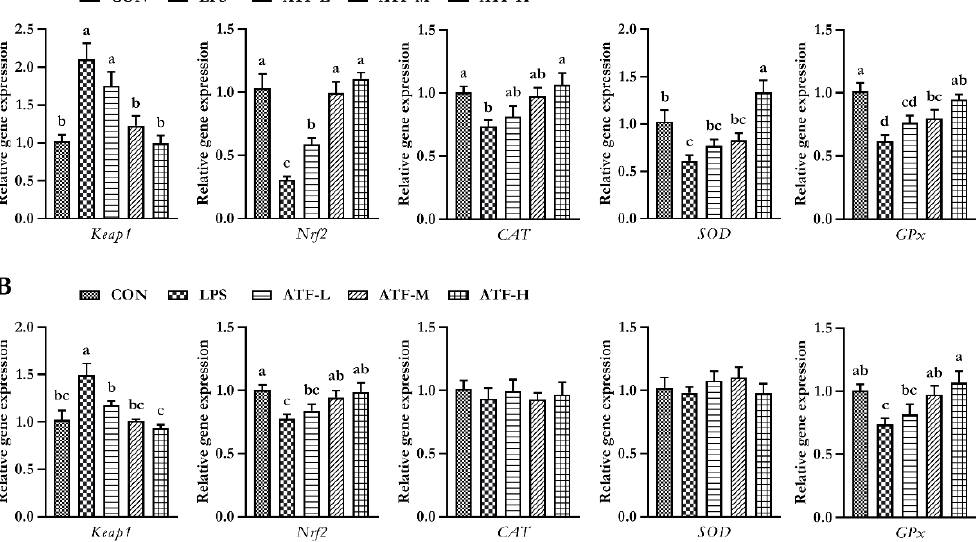
Figure 2. Effect of ATF on the expression of antioxidant-related genes in the spleen of broilers challenged with LPS. ( A ) The data of antioxidant-related gene expression in the spleen of broilers at 28 days. ( B ) The data of antioxidant-related gene expression in the spleen of broilers at 42 days. Abbre- viations: Keap1, Kelch-like ECH-associated protein-1; Nrf2, nuclear factor-erythroid 2-related factor 2; CAT, catalase; SOD, total superoxide dismutase; GPx, glutathione peroxidase; ATF, Artemisia or- dosica alcohol extract; CON, non-challenged broilers fed a basal diet; LPS, lipopolysaccharide-chal- lenged broilers fed a basal diet; ATF-L, lipopolysaccharide-challenged broilers fed a basal diet sup- plemented with 500 mg/kg ATF; ATF-M, lipopolysaccharide-challenged broilers fed a basal diet supplemented with 750 mg/kg ATF; ATF-H, lipopolysaccharide-challenged broilers fed a basal diet supplemented with 1000 mg/kg ATF. Each value is shown as the mean and standard error of mean (SEM) ( n = 6); Bars with different letters (a, b, c, and d) are significantly different ( p < 0.05), while bars with the same letter indicate no significant difference between groups ( p ≥ 0.05 ). 4. Discussion The study of safe and environmentally friendly herbal extracts has recently gained much attention on account of their potent bioactivities, such as antioxidant and anti-in- flammatory effects. Nonetheless, how different extracts from different medicinal plants regulate the balance between ROS and antioxidants triggered during oxidative stress re- mains to be further investigated. In the present experiment, we applied a classical E. coli LPS-stimulated model to induce oxidative injury in broilers by intraperitoneal administra- tion of LPS and evaluated the effect of ATF on an LPS-induced oxidative stress broiler model. In the current study, we found that LPS challenge decreased the BW and ADG in both the stress period and convalescence compared to those in the unchallenged broilers, which was possibly due to simultaneously compromised ADFI. This is consistent with the findings of Li et al. [32] and Yang et al. [50], where LPS-induced growth retardation was reported in broilers exposed to 500 μg/kg BW LPS. This phenomenon could be linked to the diversion of dietary nutrients from growth to support inflammatory-related processes, such as the synthesis of cytokines and various acute proteins [51]. Another possible reason for the observed phenomenon could be the ability of the overproduction of inflammatory cytokines to lose appetite via the control of the hypothalamic − pituitary − adrenal axis-as- sociated antioxidant process, which was reflected in the decrease of ADFI in the LPS group broilers in the present study [52]. We also observed that dietary ATF alleviated the decreased BW (all three ATF treatments), as well as improved the ADG and ADFI (1000 mg/kg ATF treatment) in LPS-challenged broilers during the stress period and